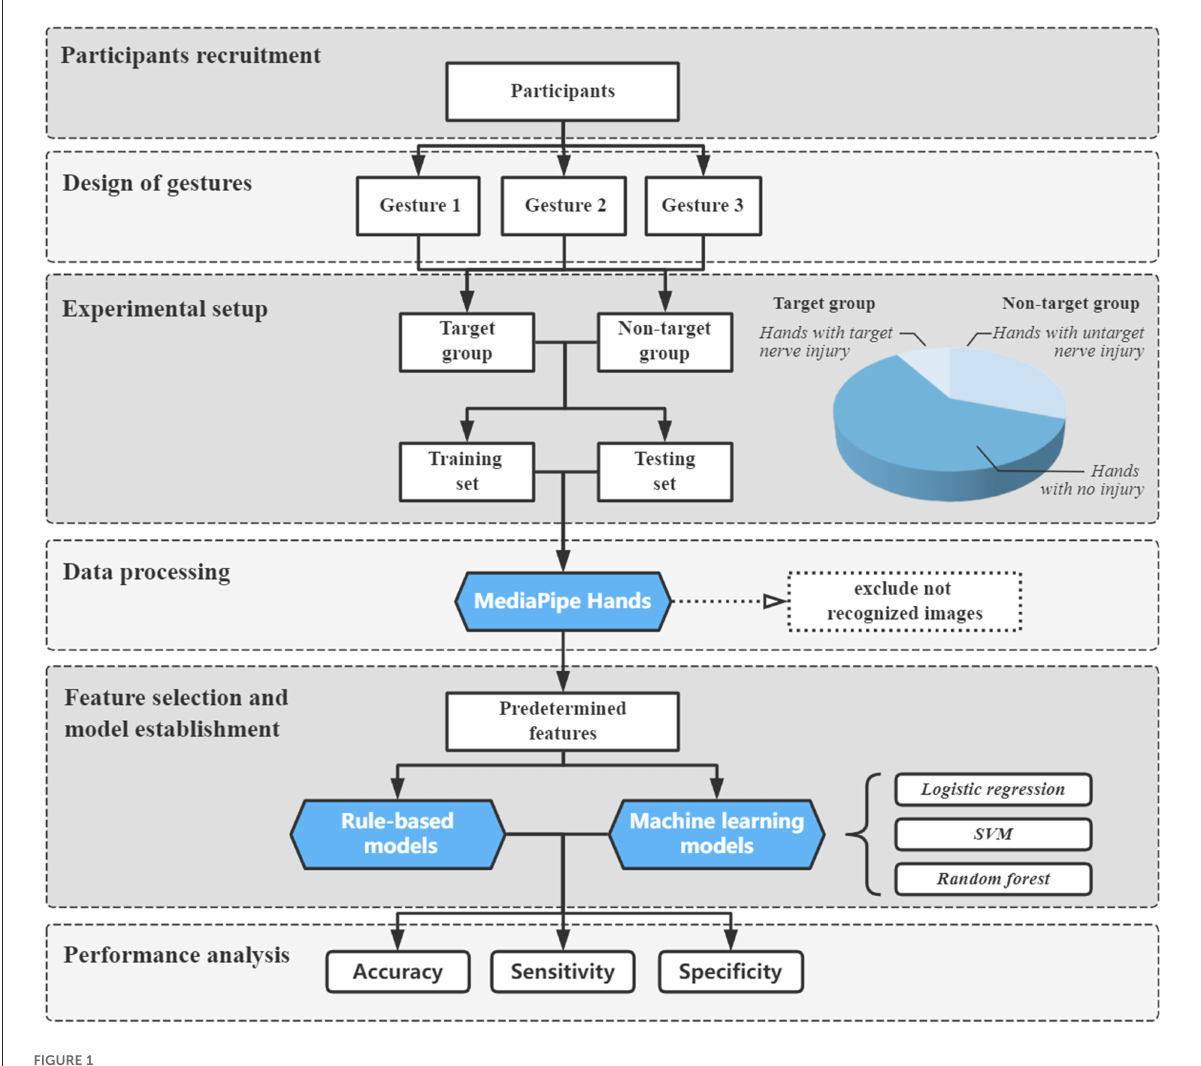
FIGURE1 Diagram of the experimental